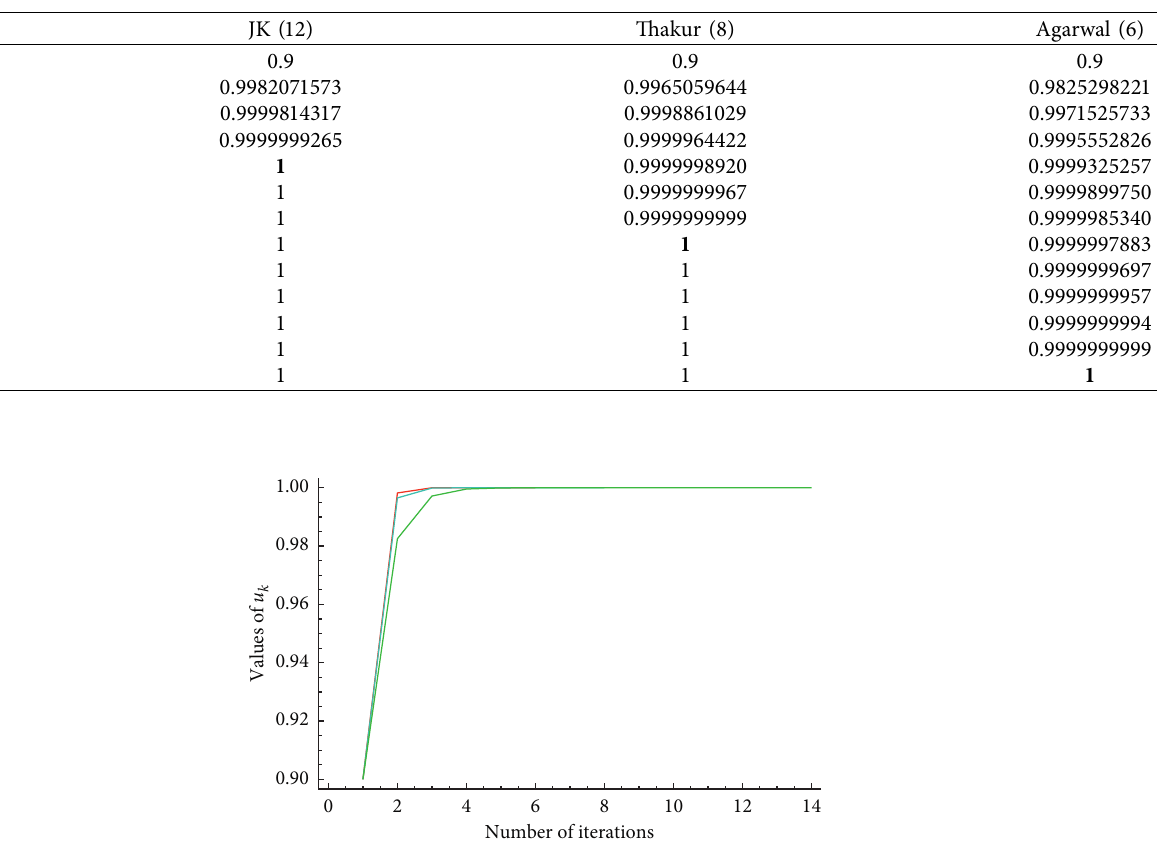
Table 1: Sequences defined by JK, Thakur, and Agarwal iterative methods for mapping F defined in Example 1.